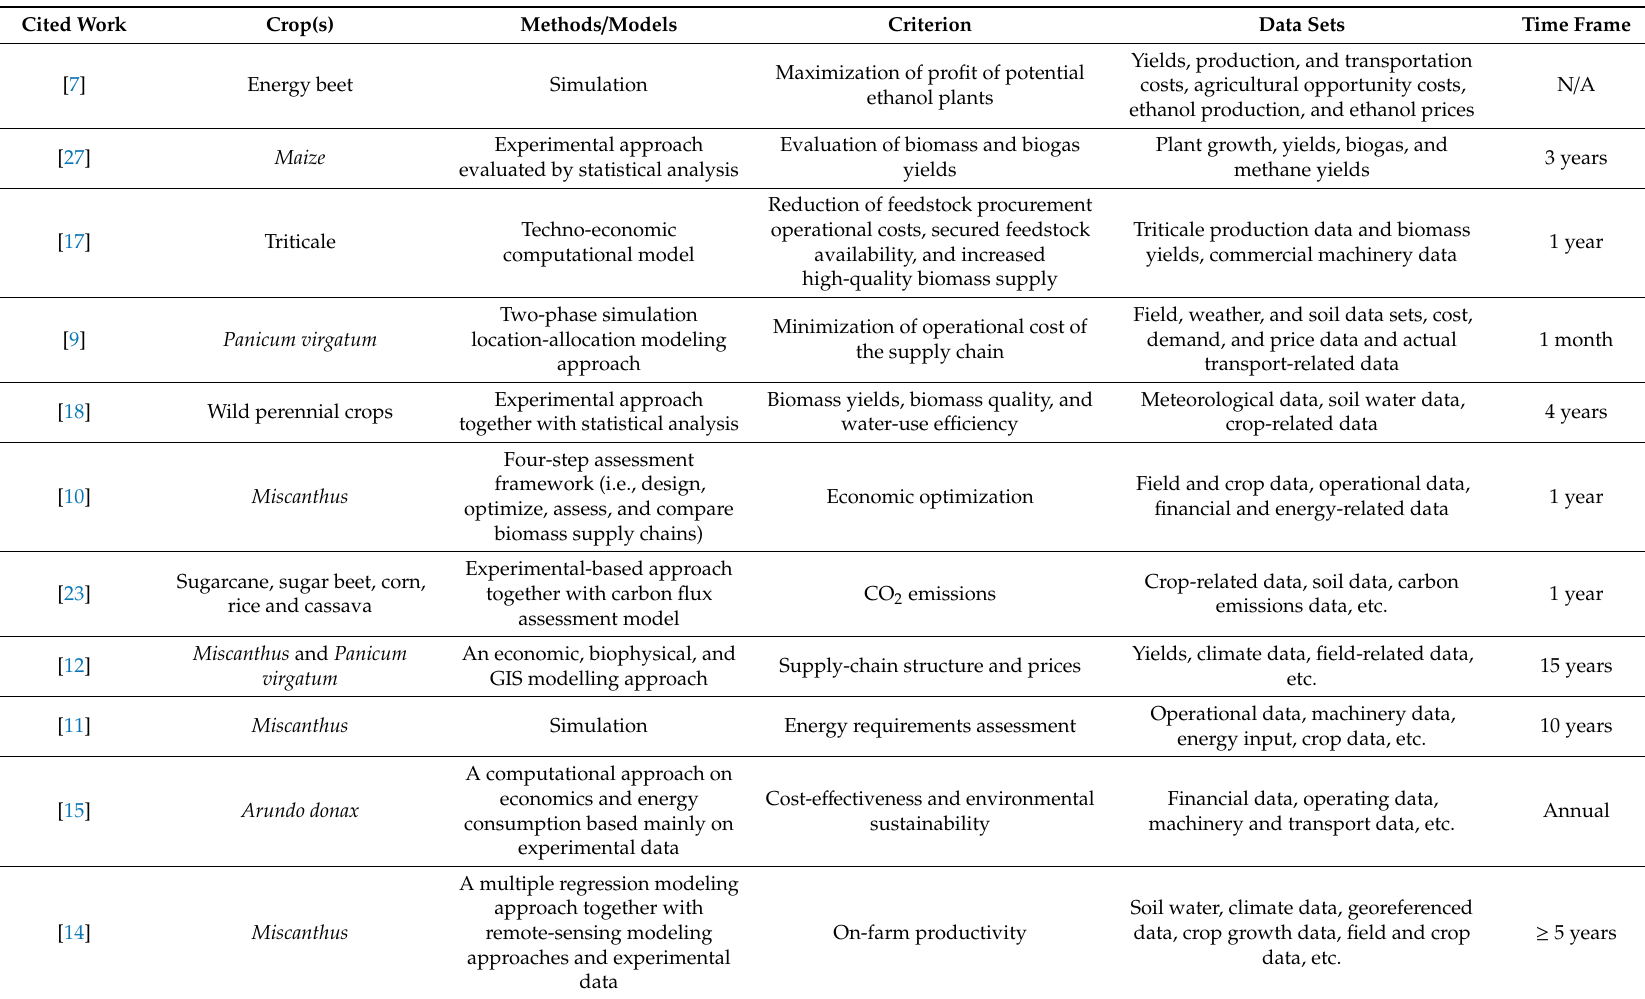
Table 1. Green-type biomass cited studies classified by crop and